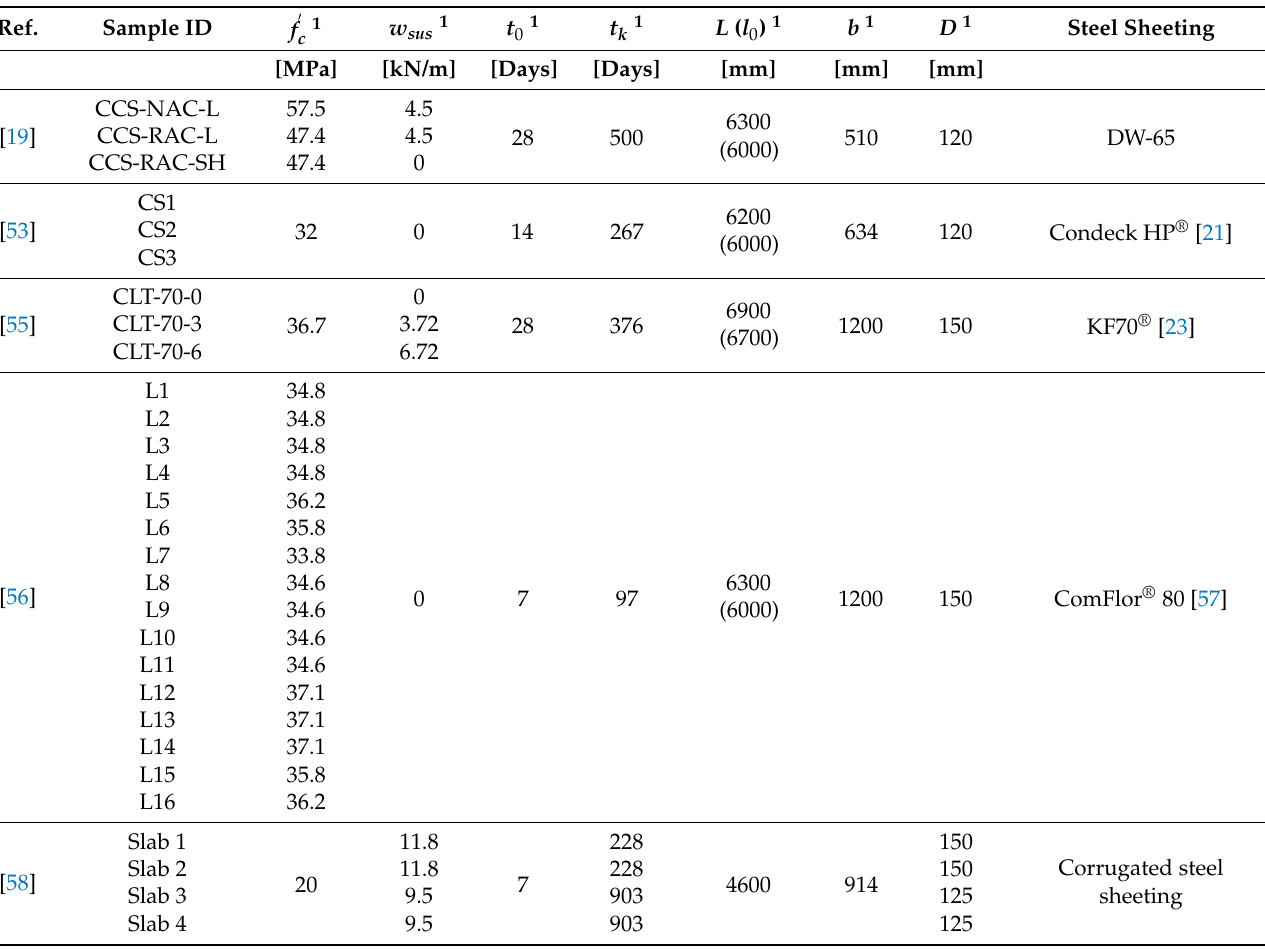
Table 3. Long-term tests of two-span continuous composite